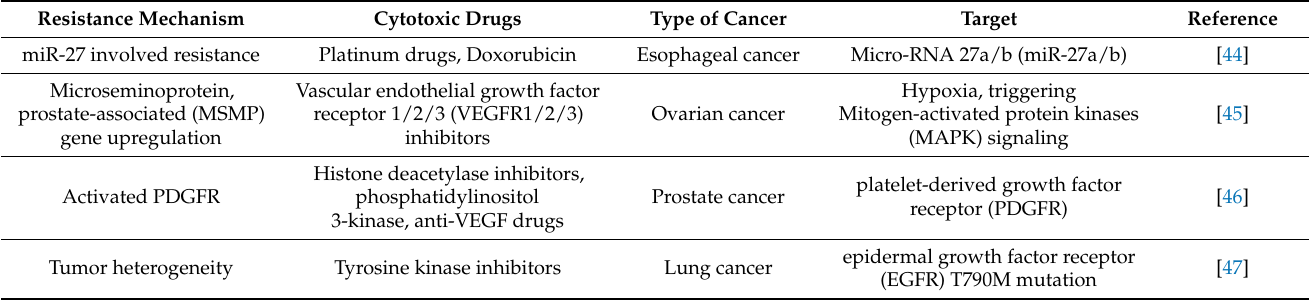
Tyrosine kinase inhibitors Lung